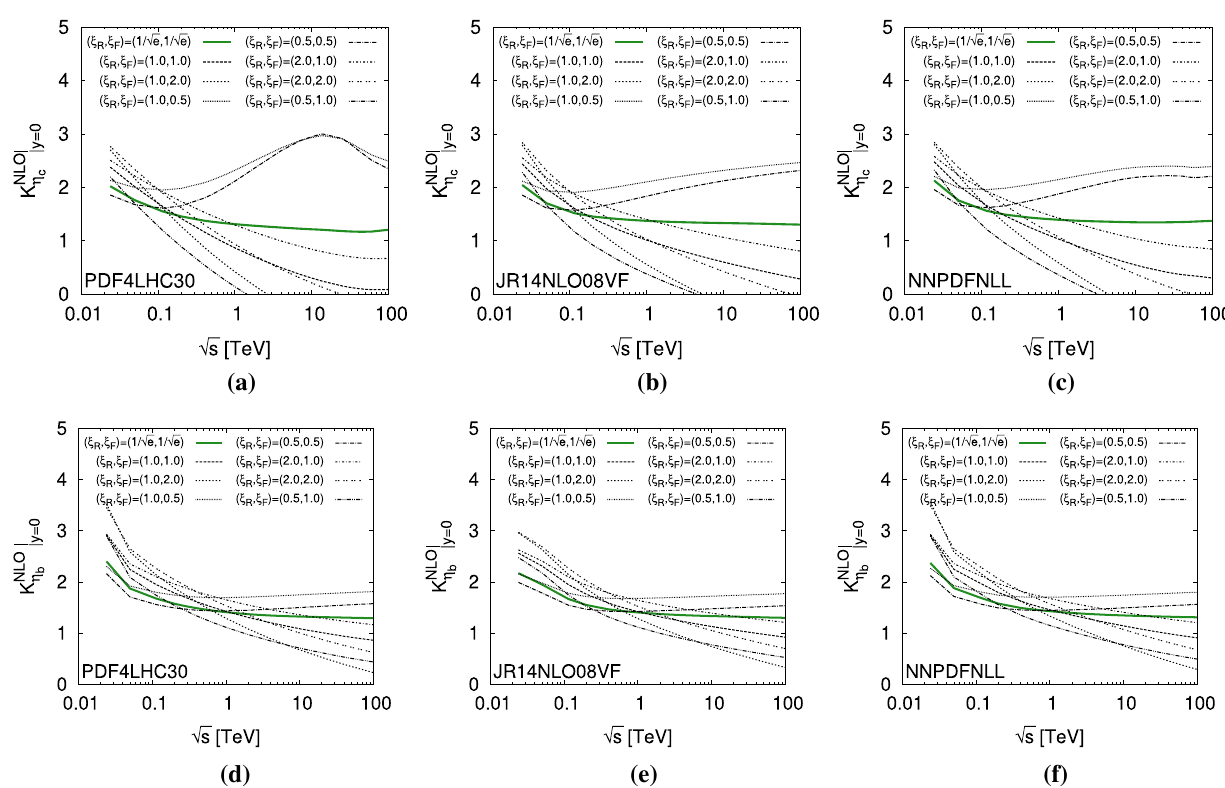
Fig. 3 K NLO | y = 0 for η c (top) and η b (bottom) (for PDF4LHC15_nlo_30 (left), JR14NLO08VF (middle) and NNPDF31sx_nlonllx_as_0118 √ s for the usual 7-point scale choices (with the notation ξ R , F ≡ μ R , F / M ) and our ˆ μ F scale (here, ˆ μ F = M / (right)) as a function of μ = μ R